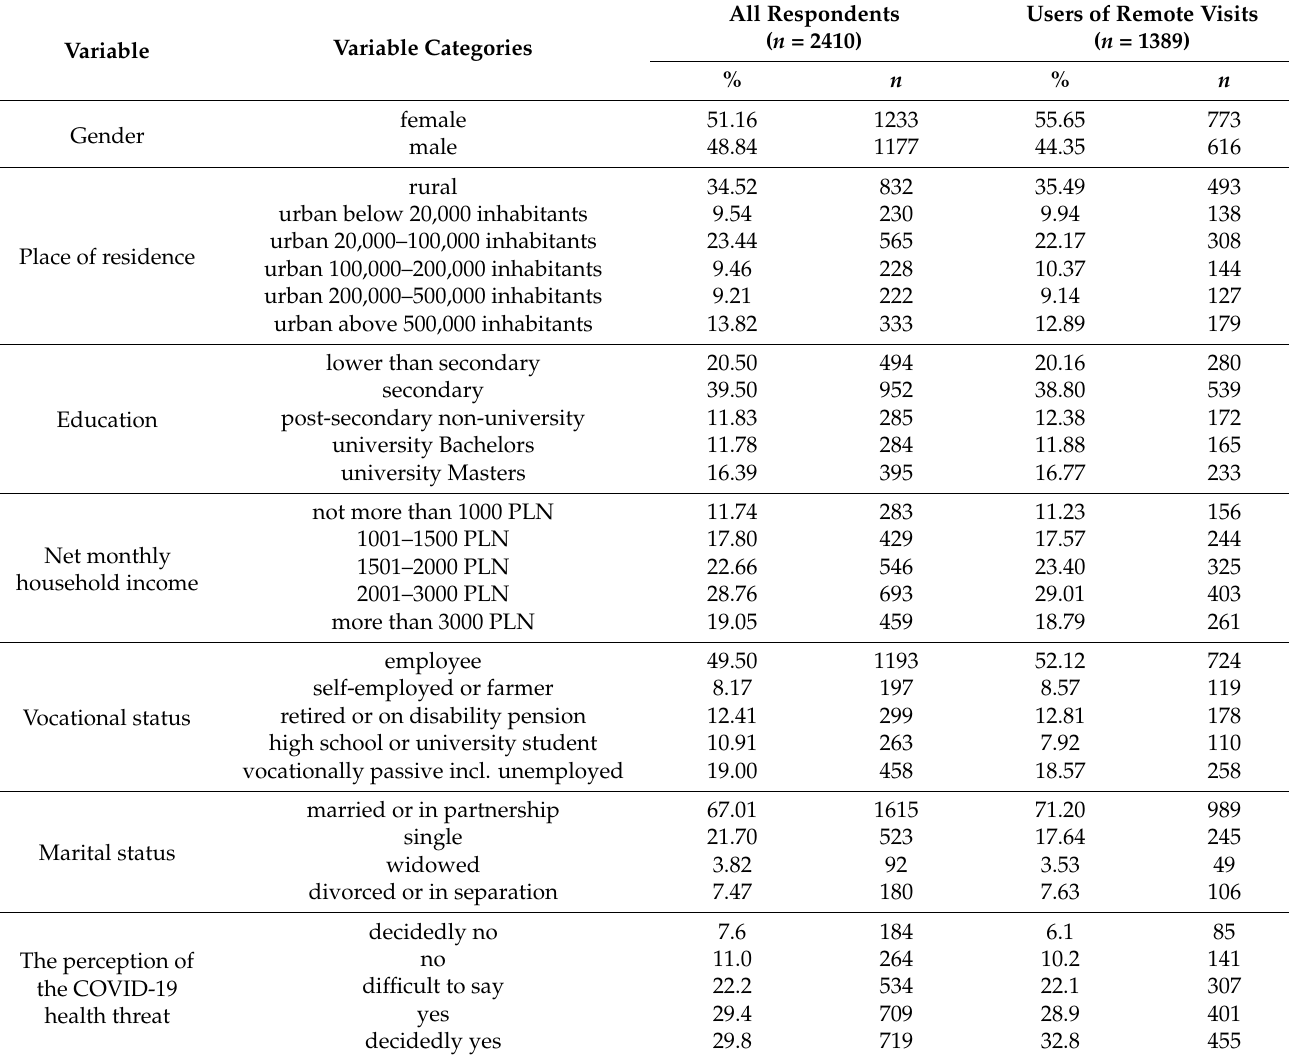
Table 1. Characteristics of the study